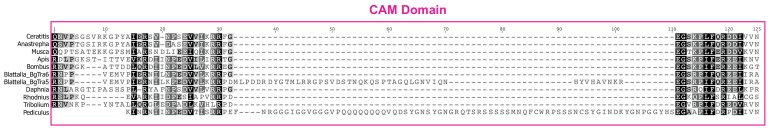
MAFFT protein alignment of the complete CAM domain in nine different insect species and one crustacean.The cockroach Blattella germanica has three different types of transcripts: some transcripts terminate halfway through the CAM domain (BgTra1, BgTra2), others code for an intact CAM domain (BgTra6, BgTra7, BgTra8), and in some the inclusion of an alternatively spliced exon interrupts the CAM domain with 47 additional residues (BgTra3, BgTra4, BgTra5).